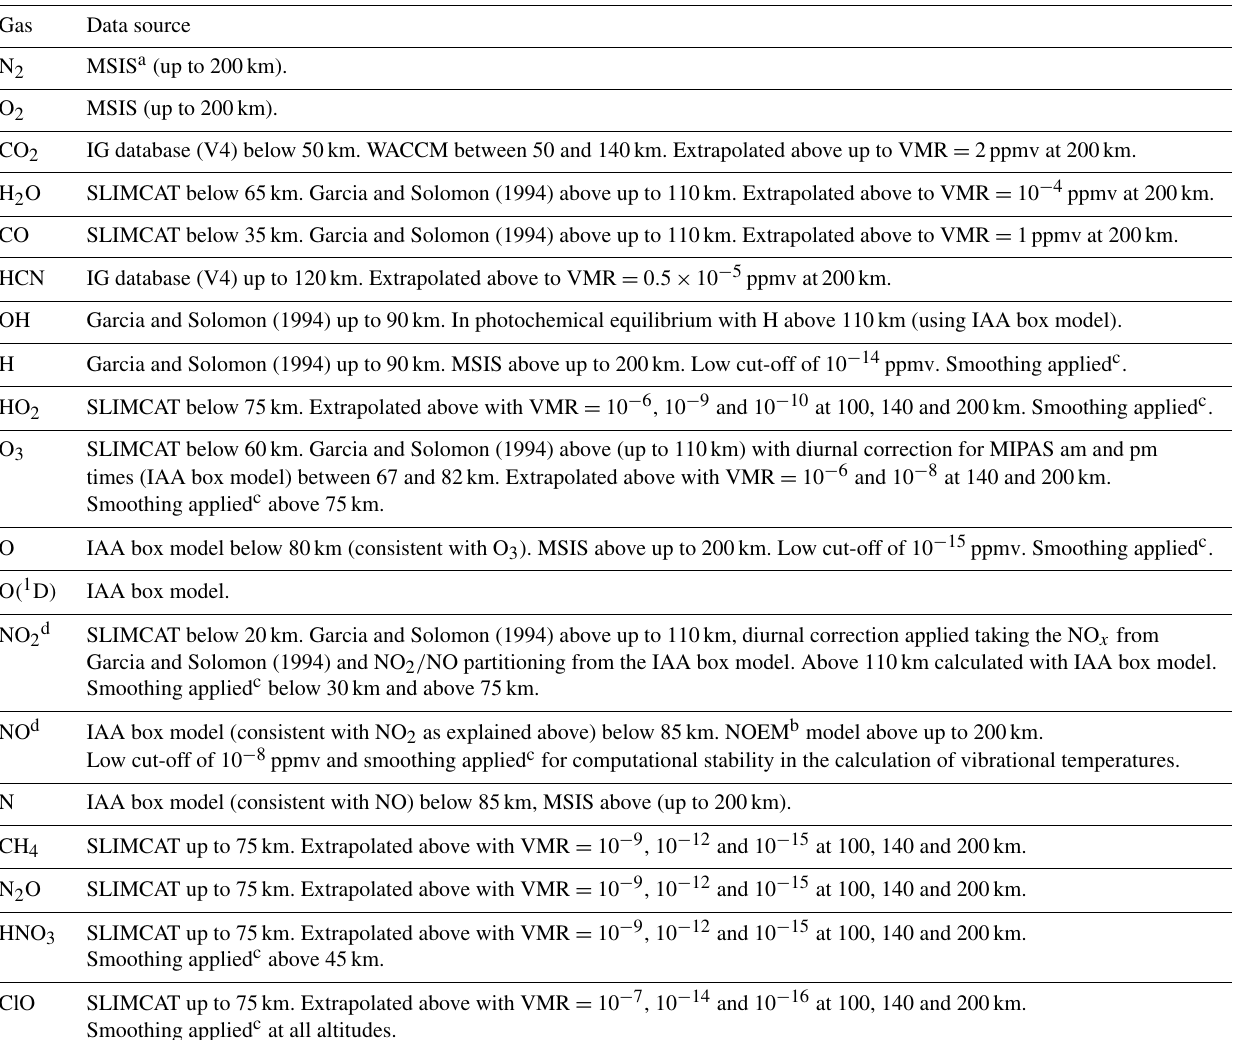
Table A1. Summary of the changes introduced in the SLIMCAT output to generate the IAA data